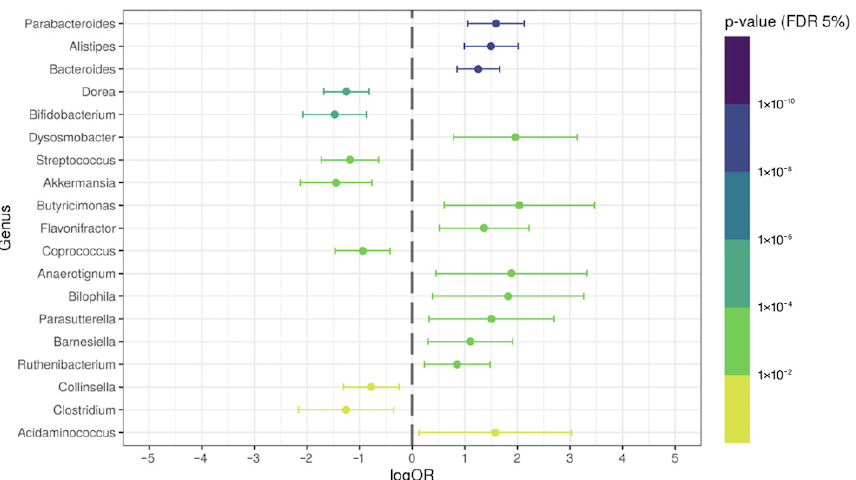
Figure 5. Differential genera relative abundance analysis of the intestinal microbiota in post-COVID-19 patients with ATB therapy ( n = 114), compared with control subjects ( n = 71).